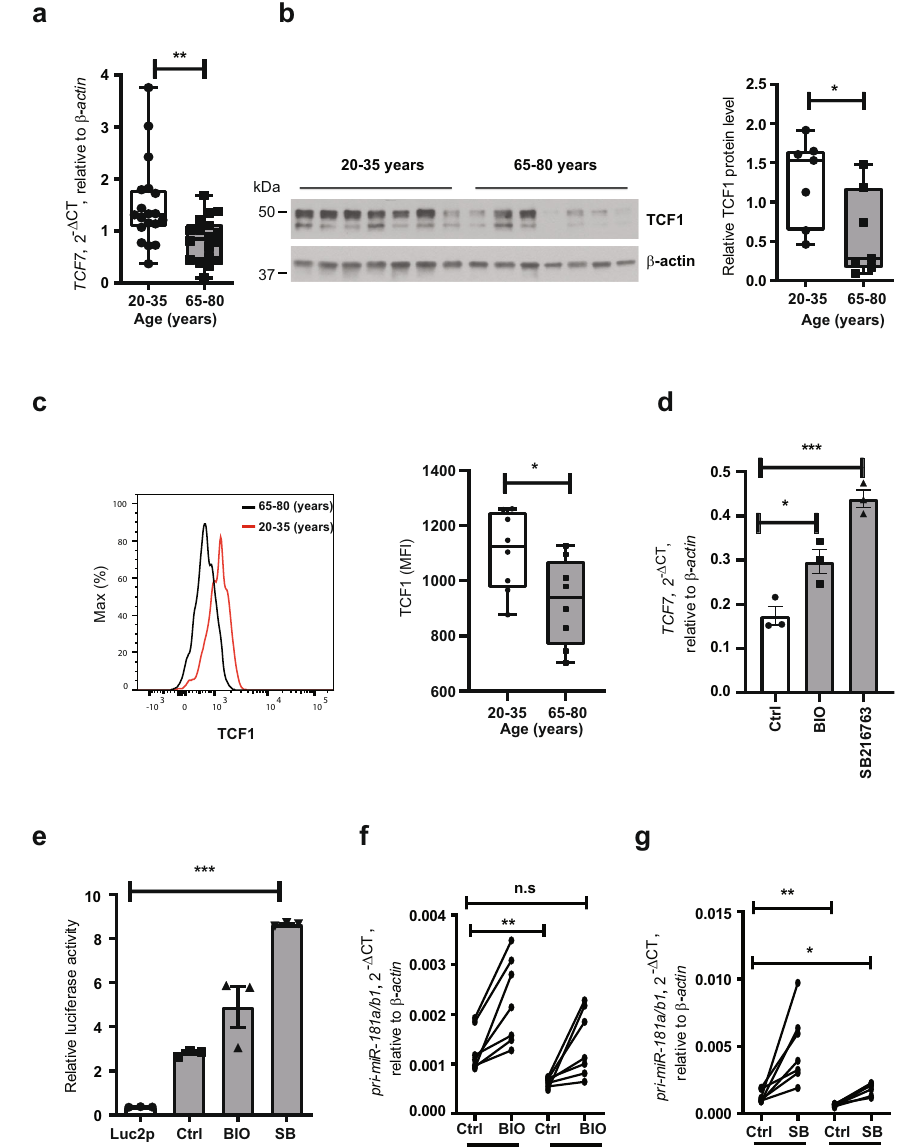
Fig. 2 Restoration of miR-181a expression in old naive CD4 T cells by inducing TCF1 activity. a TCF7 transcripts in naive CD3 + CD4 + CD45RO- T cells were quanti fi ed by qPCR. Results for 20 – 35 ( n = 19) and 65 – 85 ( n = 18) year-old individuals are shown as box plots of TCF7 transcripts relative to ACTB . b TCF1 protein levels in CD3 + CD4 + CD45RO- naive T cells from seven young and seven old adults are shown as Western blots (left) and box plots of relative densities (right). Uncropped Western blots in Supplementary Figure 4. All samples in the blot derive from the same experiment and were processed in parallel. c TCF1 expression levels in naive T cells from eight young and eight old adults are shown as representative histograms (left) and summary box plots (right). d Naive CD4 T cells from old individuals were treated with GSK3 β inhibitors 6-bromoindirubin-3-oxime (BIO) or SB216763 for 48 h. TCF7 transcripts quanti fi ed by qPCR are shown as mean±SEM ( n = 3). e BIO (1 µM) or SB216763 (5 µM) were added to HEK293T cells transfected with pri-miR-181a enhancer reporter constructs 12 h